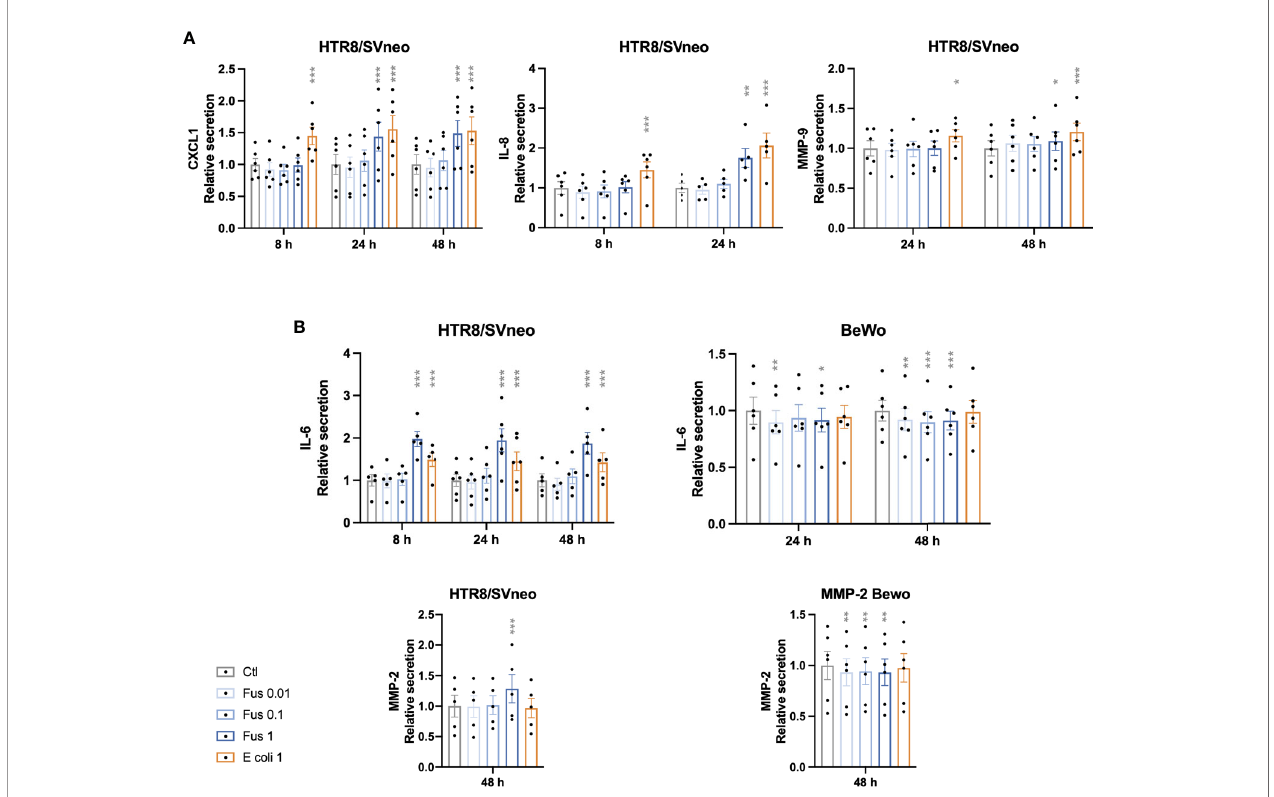
FIGURE 4 | Inactivated F. nucleatum and E. coli augment secretion of pro-in fl ammatory cytokines and MMPs by HTR8/SVneo cells. Bar graphs represent secretion of cytokines and matrix metalloproteinases (MMP) by trophoblast cell lines after stimulation with F. nucleatum normalized to respective unstimulated controls (A, B). Data are presented as mean ± SEM. *p adj < 0.05; **p adj < 0.01; ***p adj < 0.001 as analysed by Repeated Measures ANOVA with Dunnett ’ s multiple comparison post test, comparing each treatment against the corresponding control. Experiments were performed 5 (IL-8, MMP-2 and IL-6 in HTR8/SVneo) or 6 (CXCL1, MMP-9 and IL-6 in BeWo) times in duplicate. Each point represents the mean value of the replicates for each experiment. Ctl: control; Fus: ratio of F. nucleatum to cell number (if no number given ratio is 1); E. coli 1: ratio of E.coli to cell number =